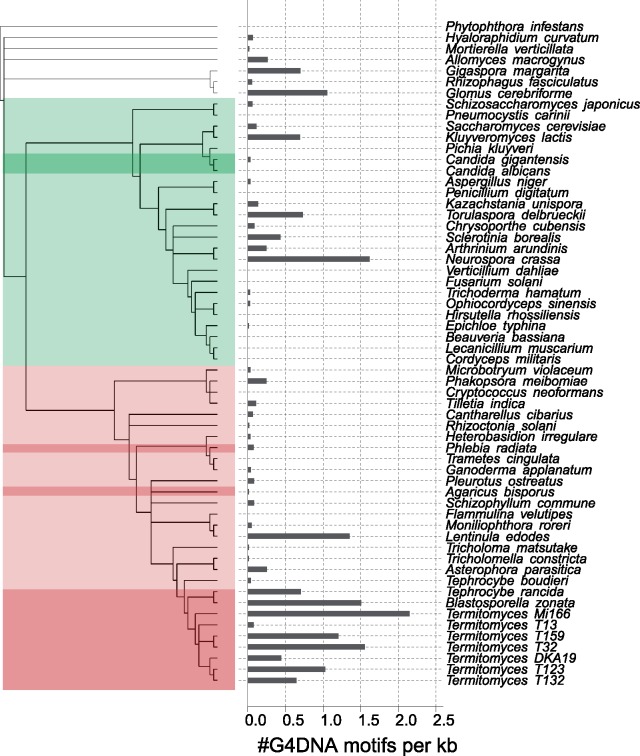
—Barplot showing average G4DNA motif content per 1-kb mtDNA for 62 species. Values were estimated with strict settings in G4Hunter (w = 25, s = 1.7). The phylogenetic tree was reconstructed using Maximum Likelihood with IQtree. Nodes with <70 bootstrap support were collapsed into polytomies. The tree was rooted with Phytophthora infestans. Ascomycetes are shaded in green and Basidiomycetes in red. Species with mitochondrial IRs are shaded in a darker hue.